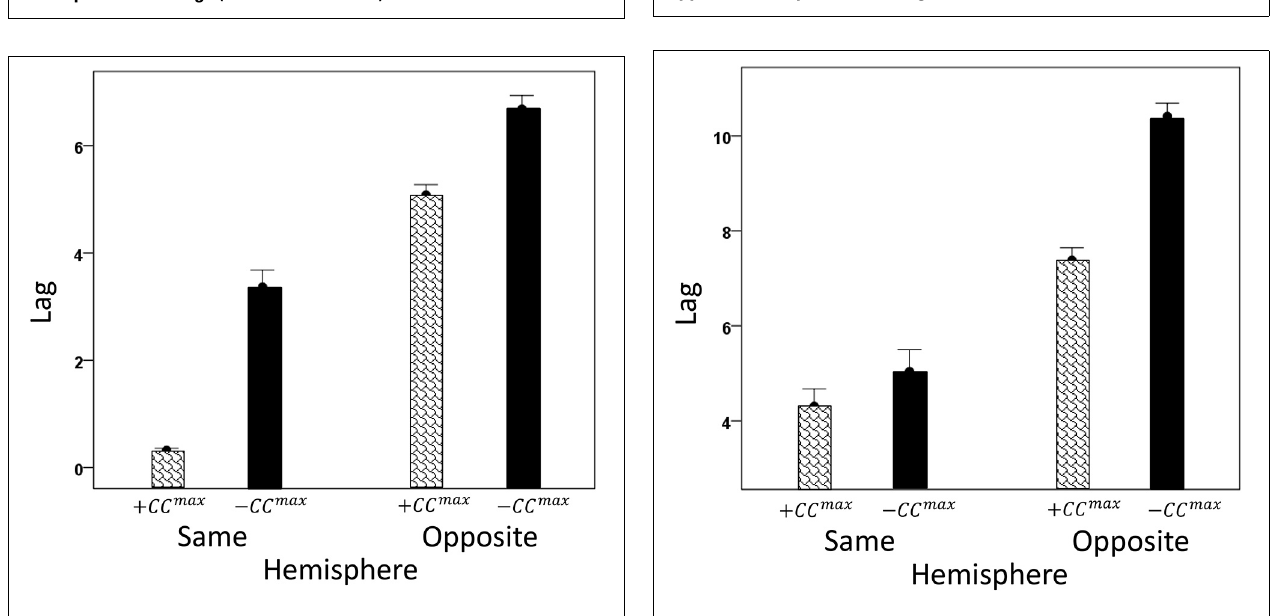
FIGURE 10 | Mean off-zero lags ( ± s.e.m.) of opposite hemisphere recordings (see text for details).